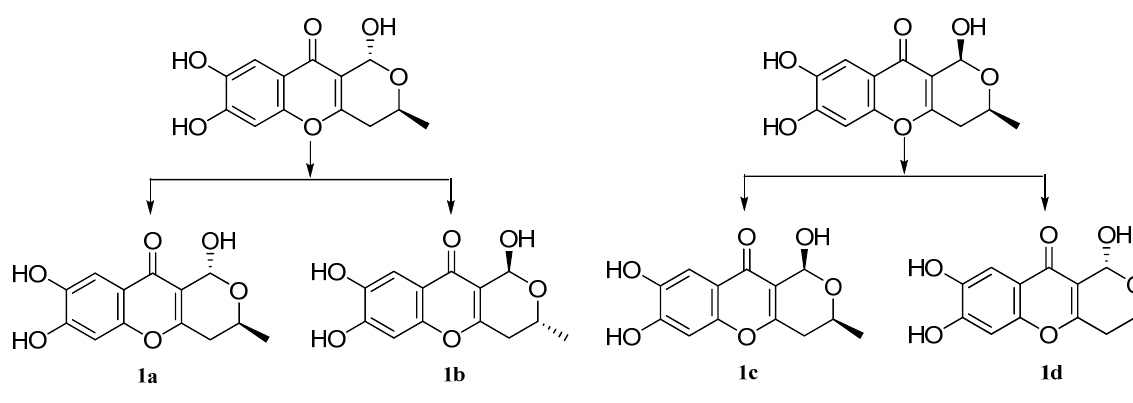
Figure 3. Two possible relative and four absolute configurations of 1 .